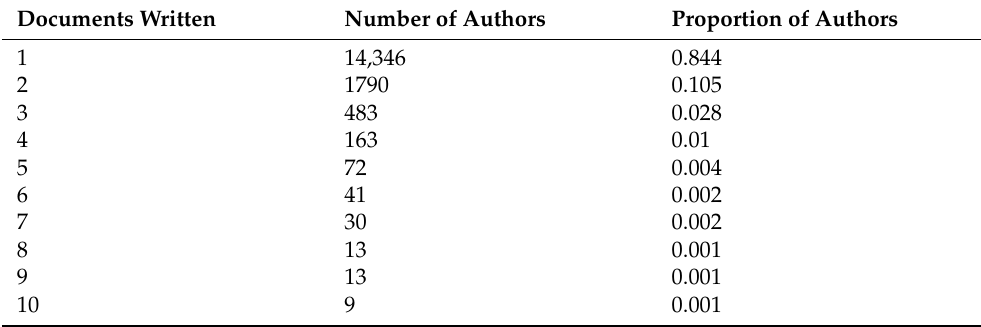
Figure 8. Frequency distribution of scientific productivity (Lotka’s law). Table 4. Frequency distribution of scientific productivity according to Lotka’s